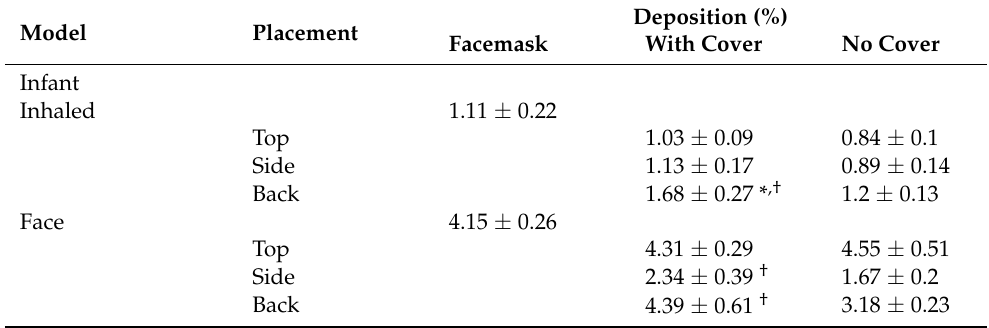
Deposition (%) Facemask With Cover No Cover